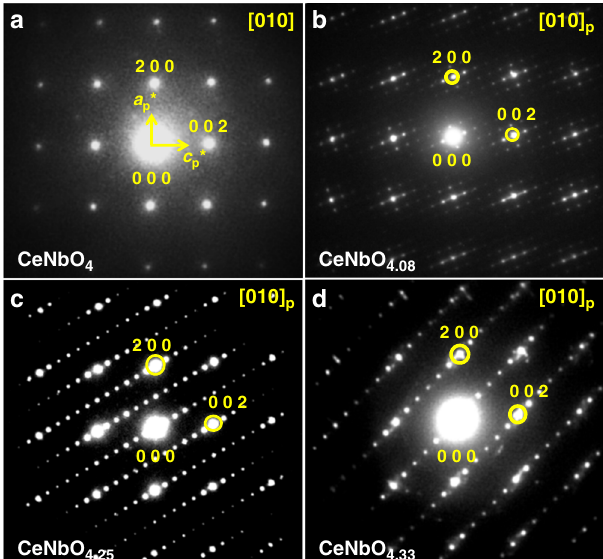
Fig. 1 [010] p zone axis SAED of CeNbO 4 + δ . a CeNbO 4.0 . b CeNbO 4.08 . c CeNbO 4.25 . d CeNbO 4.33 . The strong re fl ections in b – d have the same pseudo-tetragonal symmetry as the re fl ections of the parent structure in a . (p denotes parent material CeNbO 4